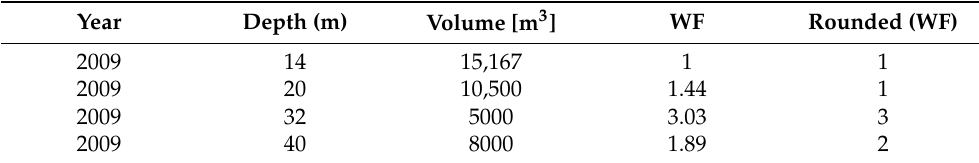
Table 1. Determination of rounded weighting factors (WF) for fish abundance (e.g., for 2009) from trawling in four water depths where the calculated WF was rounded to the nearest half integer to be used for continuous size distributions. In this example year, the maximum volume (m 3 ) fished at 14 m depth was divided by the fished volume (m 3 ) in the other respective layers to determine the WF, which was then rounded to the nearest half integer. Depth